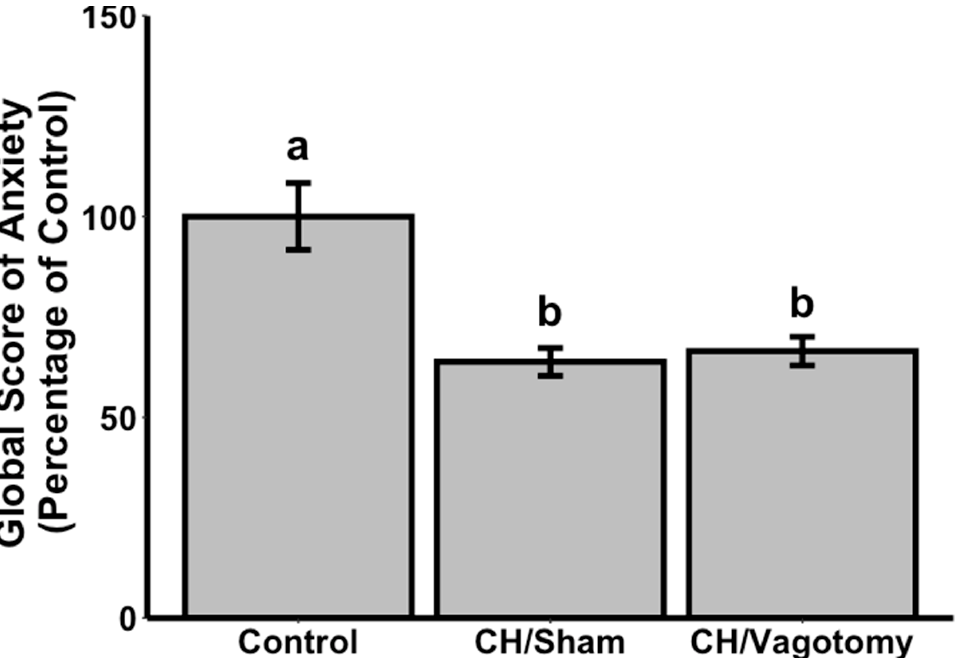
Figure 1. Effects of CH, orally administered at a single dose of 15 mg/kg, on the global score of anxiety in a conditioned defensive burying model in vagotomised male Wistar rats (n = 8 / group). Data are mean ± SEM. Means with different letters are significantly different (Mann–Whitney U-test, p < 0.05). CH, tryptic hydrolysate of bovine α s1 -casein.